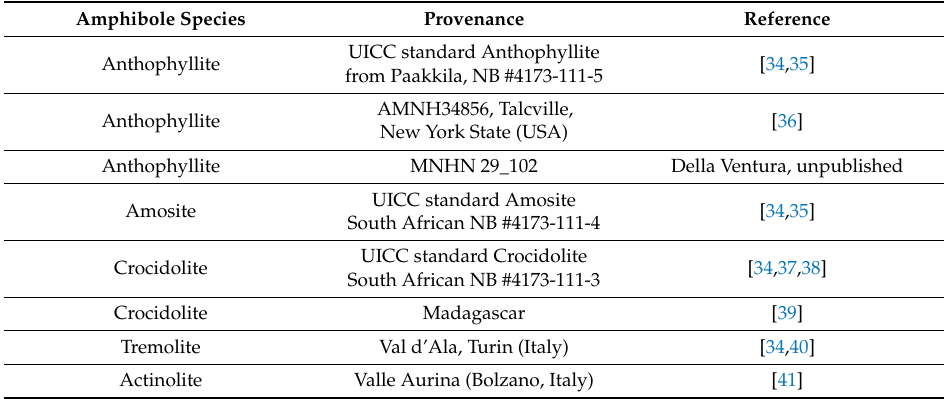
Table 1. Studied samples.